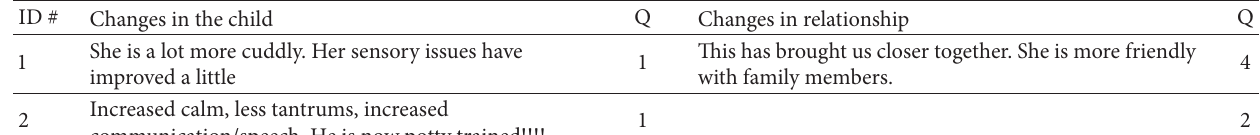
Table 5: Parent comments on changes in the child and changes in